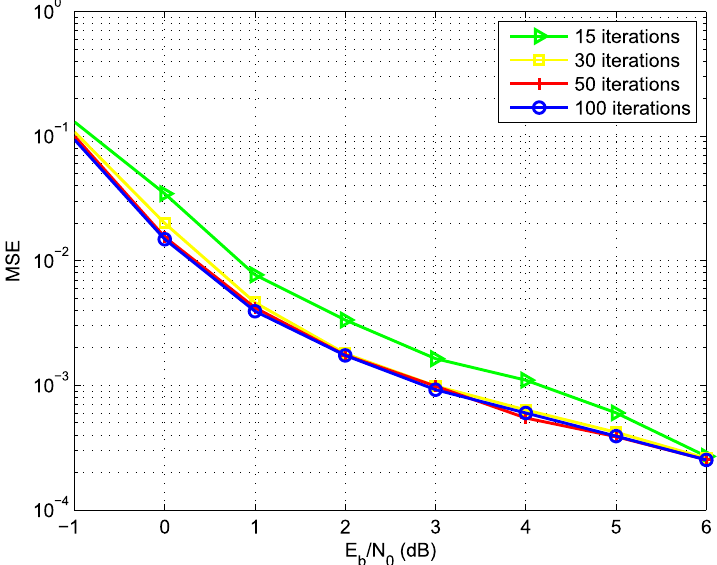
Fig. 7 MSE curves of the proposed algorithm for an LDPC code of length n = 1944 bits, rate R = 1 / 2 , and u i = 6 , for different number of iterations of the gradient